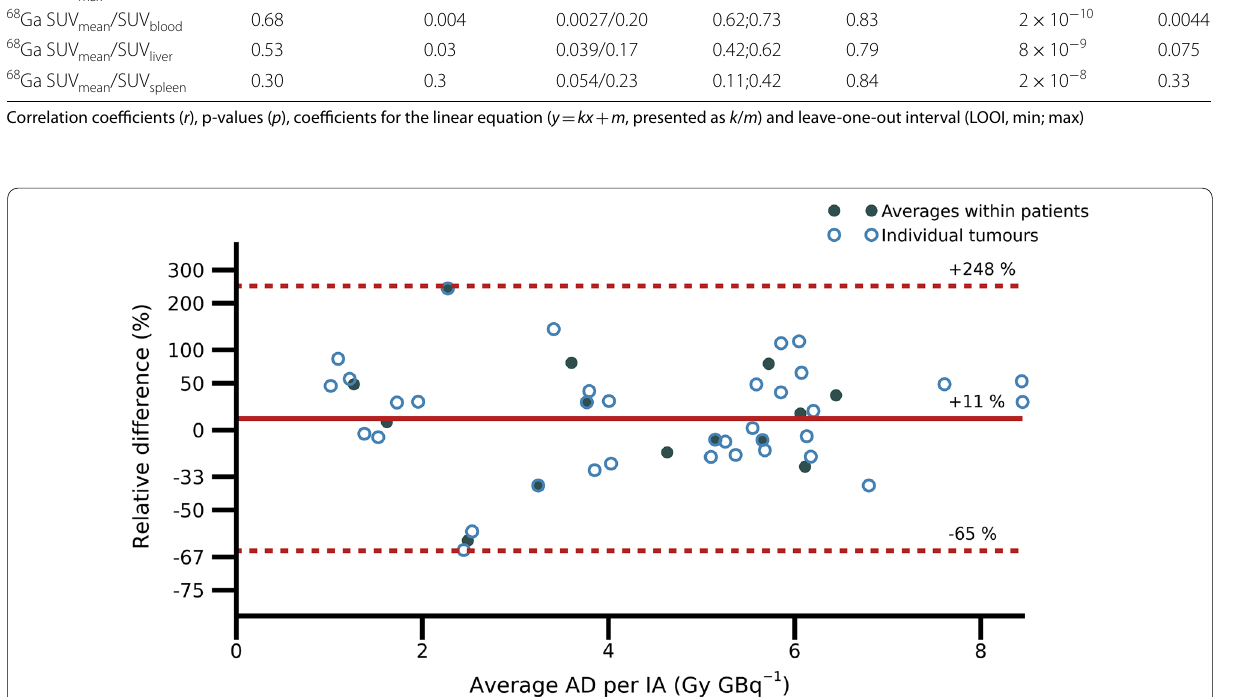
Fig. 5 Bland–Altman plot of tumour absorbed doses estimated from 68 Ga-PET images and 177 Lu SPECT. Quantification of the mean deviation (solid line) and the 95% coverage interval (dashed lines) was based on the average tumour absorbed doses for each patient (filled markers). The agreement for individual tumours is also indicated (open markers). The relative difference refers to the absorbed dose estimated from 68 Ga-PET over the absorbed dose estimated through peri-therapeutic